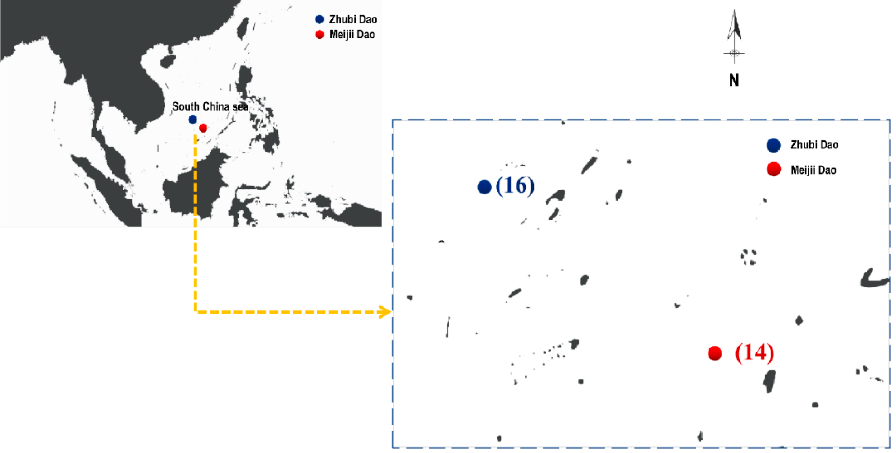
Figure 1. Locations of the 30 collected Lutjanus kasmira. Table 1. Sample information for the 30 L. kasmira collected in Zhubi Dao and Meiji Dao. Sample